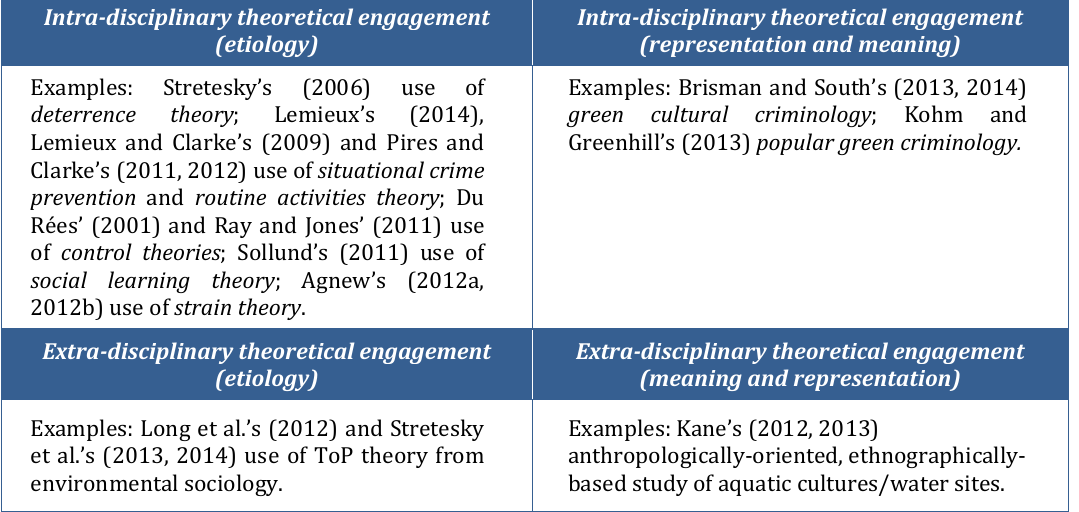
Figure 1: Conceptual representation of green criminology’s theoretical engagement (with